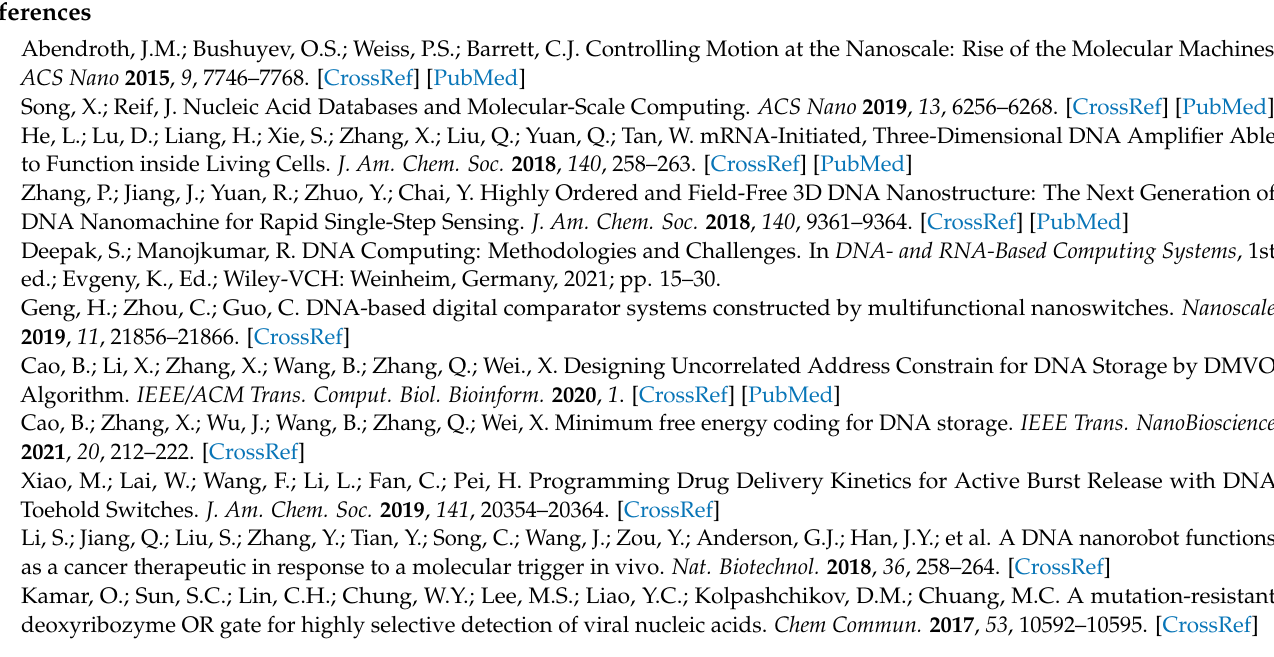
Figure S1: The fluorescence assay of the INH gate; Figure S2: The fluorescence assay of the OR gate; Figure S3: The implement of the AND gate; Figure S4: The implement of the XOR gate; Figure S5: The PAGE results in the construction of DNAzymes; Figure S6: The reaction rate of DNAzymes under different temperature; Figure S7: The PAGE analysis of the half-adder; Figure S8: The PAGE analysis of the half-subtractor; Figure S9: The PAGE analysis of the 2:1 Multiplexer; Figure S10: The PAGE analysis of the 1:2 Demultiplexer; Figure S11: The hybridization principle and the design of toehold in DNA voter; Figure S12: The fluorescence assay with six groups of different concentration of D-F; Figure S13: The fluorescence values of DNA voter; Figure S14: Design of DNA voter with (2n + 1)